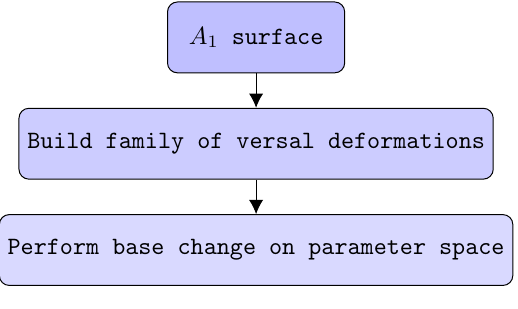
Figure 4 . The main idea exempli(cid:12)ed in the A